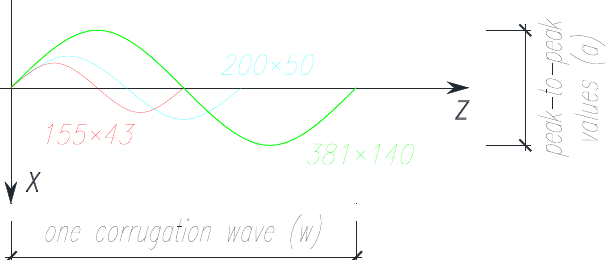
Figure 3. Sinusoidal wave geometry of the considered box profile metal sheeting webs (dimensions in mm).